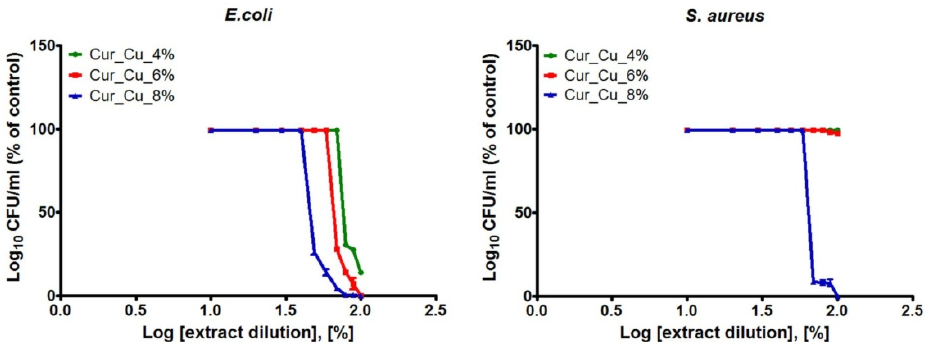
Figure 7. The antibacterial activity of extracts obtained from Cur_Cu_4%, Cur_Cu_6%, and Cur_Cu_8% biomaterials. The initial extracts (100%) were diluted in fresh MHB (90–10%) in order to determine bacterial response to extract solutions at different concentrations.